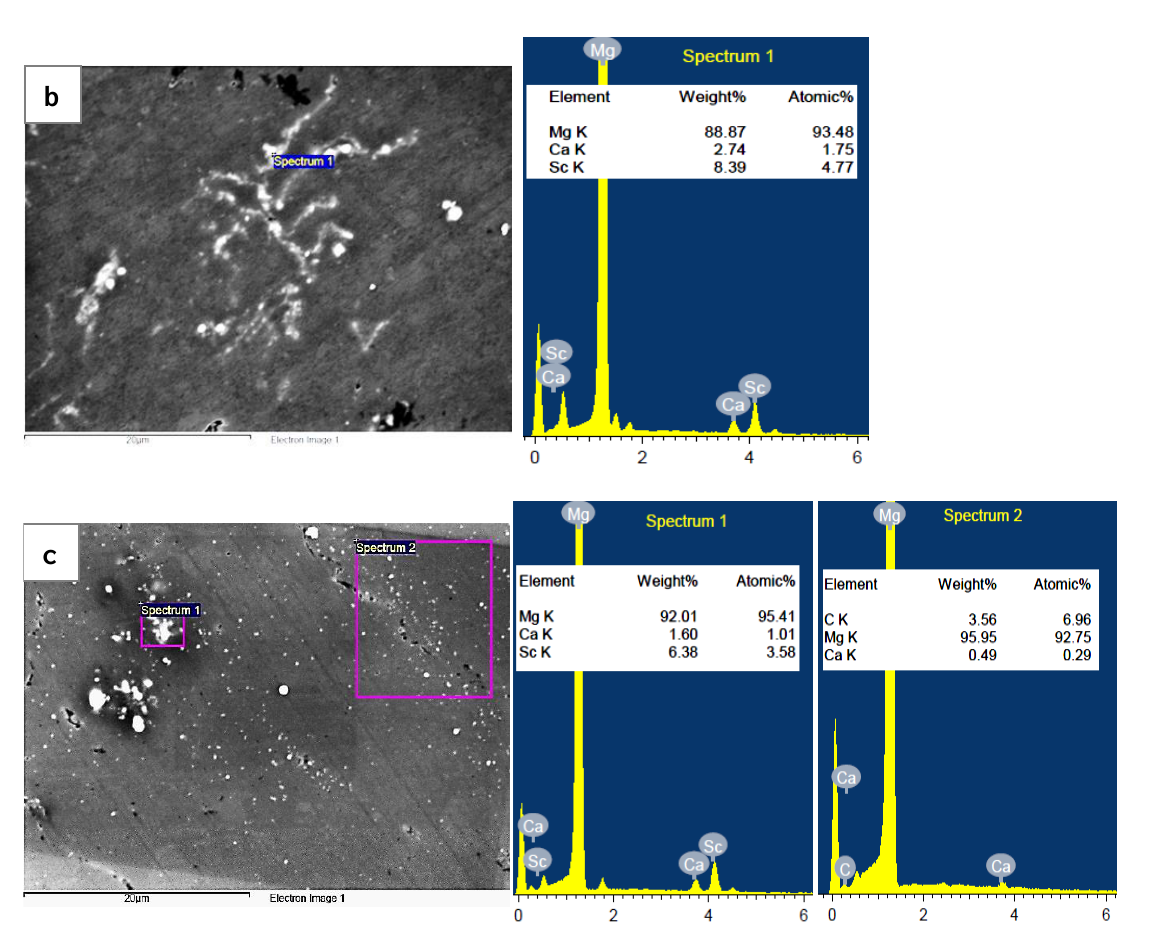
Figure 2. EDX analysis showing: ( a ) Mg and Ca peaks in Mg1Ca alloy, ( b ) Mg, Ca and Sc peaks in Mg1Ca1Sc alloy and ( c ) Mg, Ca, Sc and C peaks in Mg1Ca1Sc/1.5B 4 C composite.